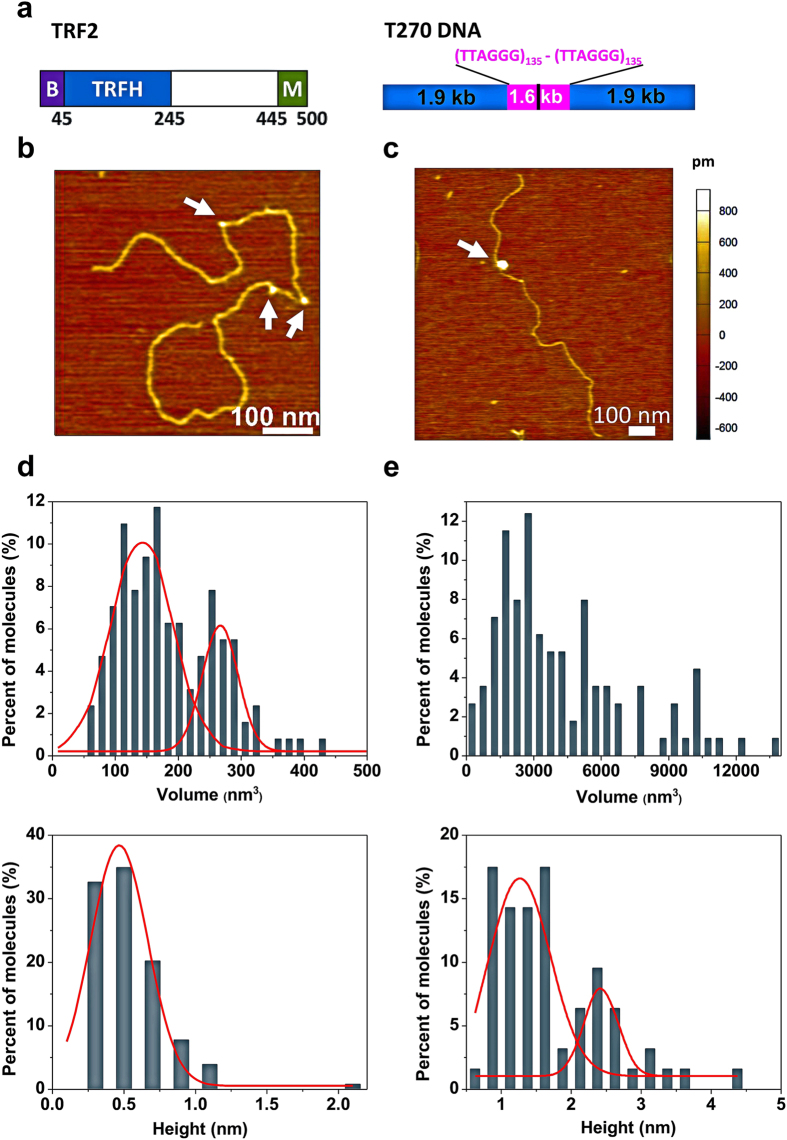
Large TRF2 complex formation on DNA involves protein stacking leading to greater complex heights.(a) Schematic representations of the domain structure of TRF2 (left) and T270 DNA substrate (right). B: the basic domain. M: the Myb type domain. T270 DNA contains two (TTAGGG)135 regions (purple) separated by a short linker region (23 bp, black) and flanking non-telomeric regions (blue). (b,c) AFM images of T270 bound by multiple small complexes (white arrows, volume < 500 nm3) with a contour length of 1702.0 nm (b) and a higher order oligomeric TRF2 complex (the white arrow, 1841 nm3) with a DNA contour length of 1457.5 nm (c). The AFM images in (b,c) are 0.5 μm × 0.5 μm. (d,e) AFM volume (top) and height (bottom) distributions of small (d, N = 134) and large TRF2 complexes (e, N = 69). The red lines are Gaussian fits to the data. The volumes of small complexes displayed two distinct peaks at 142.3 ± 93.9 nm3 and 266.6 ± 53.4 nm3 (R2 = 0.92), while their heights displayed a single peak at 0.5 ± 0.4 nm (R2 = 0.91). The heights of large complexes displayed two distinct peaks at 1.3 ± 0.8 and 2.4 ± 0.4 nm (R2 = 0.81). Note that the AFM volume distribution of TRF2 dimers on DNA is broader than protein alone (Supplementary Fig. 1c).